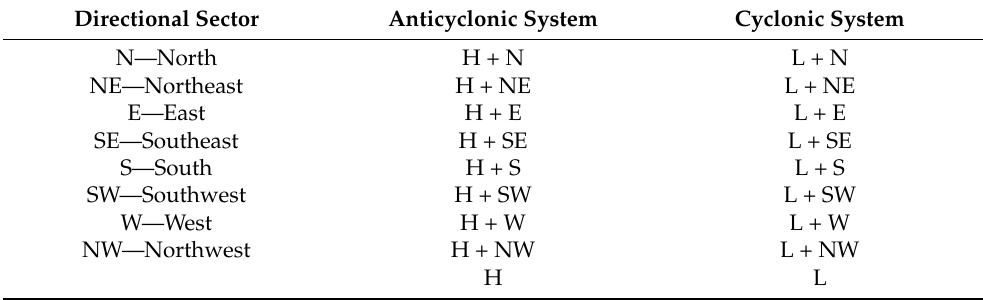
Table 3. The 26 weather circulation types generated by the classification scheme. Adapted from